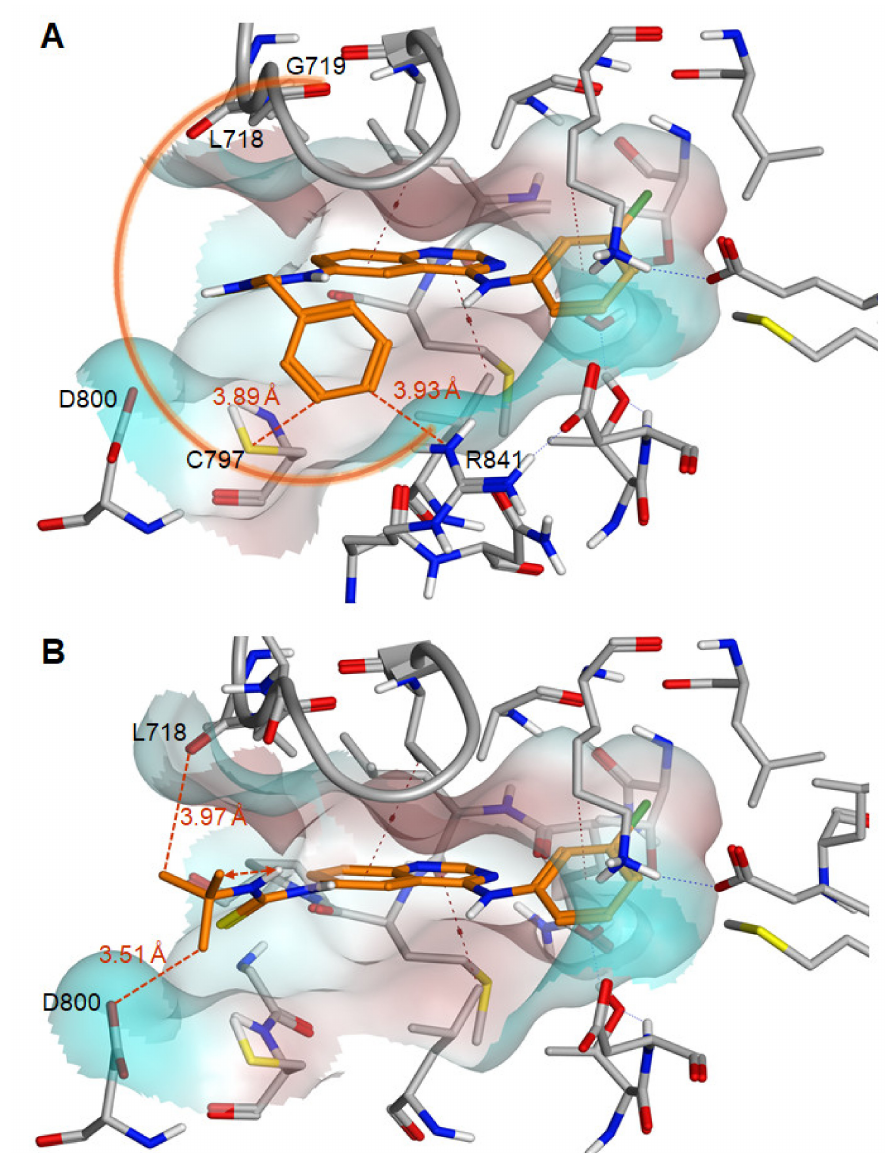
Figure 3. Design concept to abolish the EGFR inhibitory activity based on the predicted binding modes of compounds A ( A ) and 20 ( B ) in the ATP pocket of EGFR kinase. Molecular docking was performed to the coordinates of the gefitinib–EGFR cocrystal structure (PDB code: 4WKQ) as previously described using MOE [36,37]. The ATP binding pocket is shown as a transparent Connolly surface with color-encoded lipophilic (brown) and hydrophilic areas (cyan), and the ligands are drawn as orange sticks. The binding mode of the 4-aminophenyl quinazoline core superimposed well with the corresponding portion of gefitinib in the original cocrystal structure (overlay not shown for clarity). In all poses obtained, the benzyl ring in A and the t -butyl group in 20 were positioned in unfavorable close distances to polar residues at the pocket rim; these distances are shown as orange dashed lines in the depicted representative poses, and the residues are indicated. In other poses, the rotamers of the benzyl group in A closely approached the carboxylate of Asp800 or the carbonyls of Leu 718 or Gly719. The radius covered by the benzyl group is illustrated by the orange semicircle. The unfavorable eclipsed conformation of 20 ( B ) is indicated by the double arrow. The glycine-rich loop backbone is represented as a cord. Brown dashed lines: CH– π interactions; blue dashed lines: